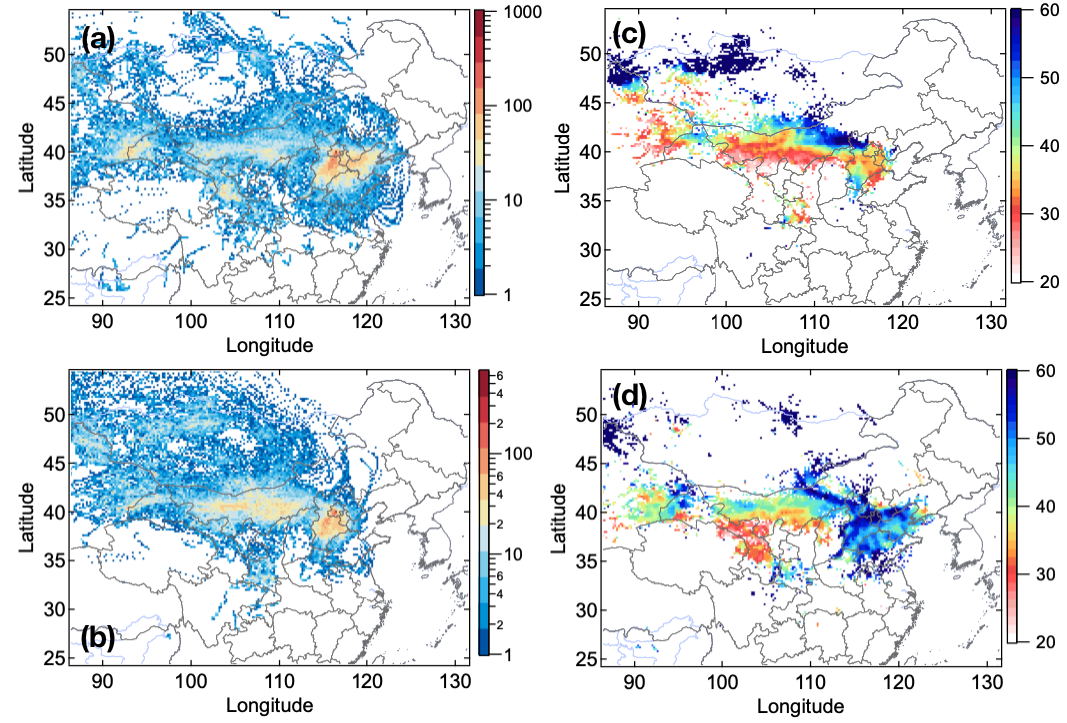
Figure 7. Footprint regions of mineral dust particles for the periods when averaged mass concentration of c NO 3 was higher than 5µgm − 3 , while δ Dp = 5 values were higher than 0.4 (a) and lower than 0.2 (b) , and corresponding mean RH (c) and (d) in each grid within the footprint area on the basis of ensemble HYSPLIT analysis. Footprint height was defined as the height that the endpoint of the backward trajectory was lower than the height of the mixing layer in that